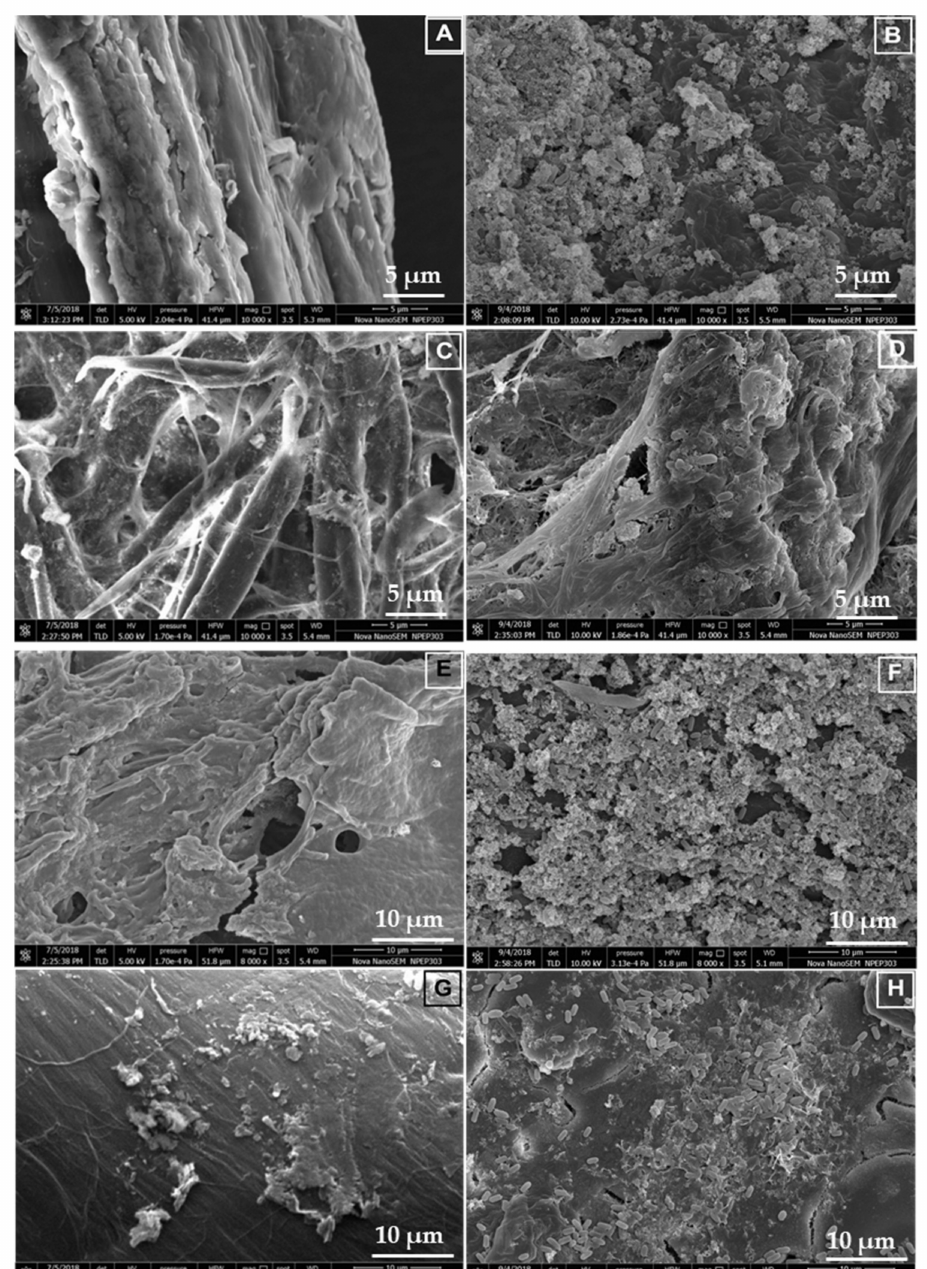
Figure 7. Hydrolysis of agro-wastes and FP used as substrates for the production of cellulases by B. altitudinis RSP75 after 8 days of incubation in BMS media. Field emission scanning electron micrograph of untreated corncob powder ( A ), treated corncob powder ( B ), untreated filter paper ( C ), treated filter paper ( D ), untreated sugarcane bagasse ( E ), treated sugarcane bagasse ( F ), untreated ( G ) and treated wheat husk ( H